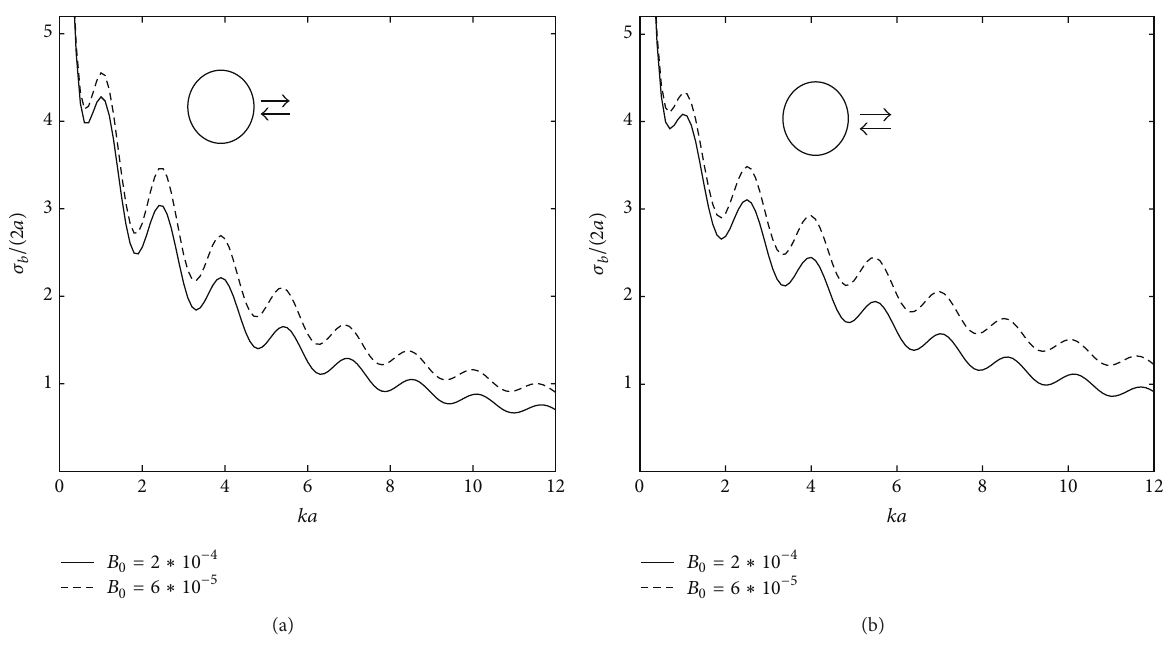
Figure 6: LRCS versus target size for 𝛿 = 0 and SCL = 2.2 in random medium where (a) 𝑘𝑊 = 2 , (b) 𝑘𝑊 = 2.5